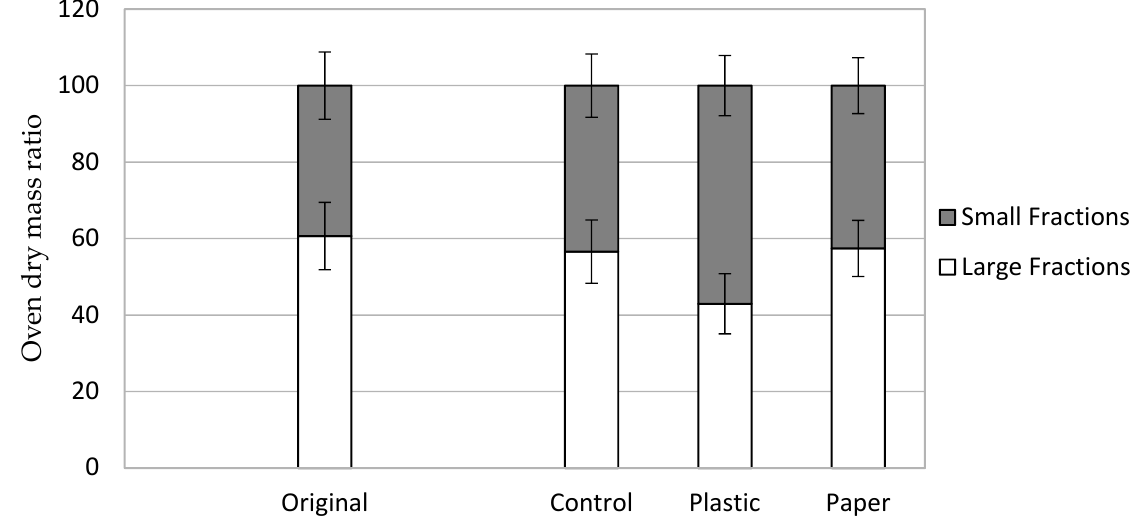
Figure 8. Change in particle size distribution (% o.d. mass ratio) of comminuted biomass after a storage period of one year.